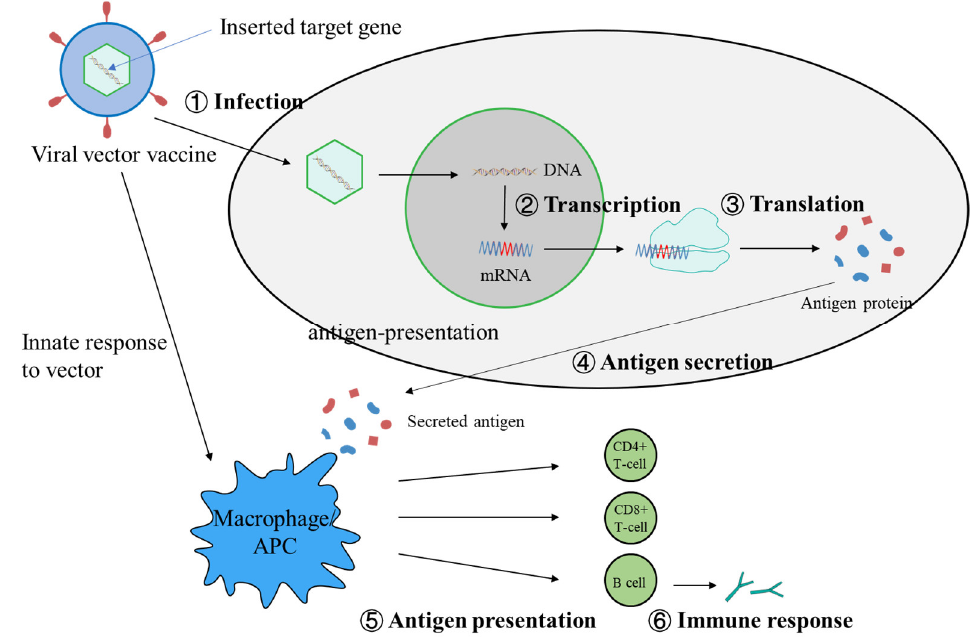
Figure 2. Mechanism of viral vector vaccines induce specific cellular and antibody responses.